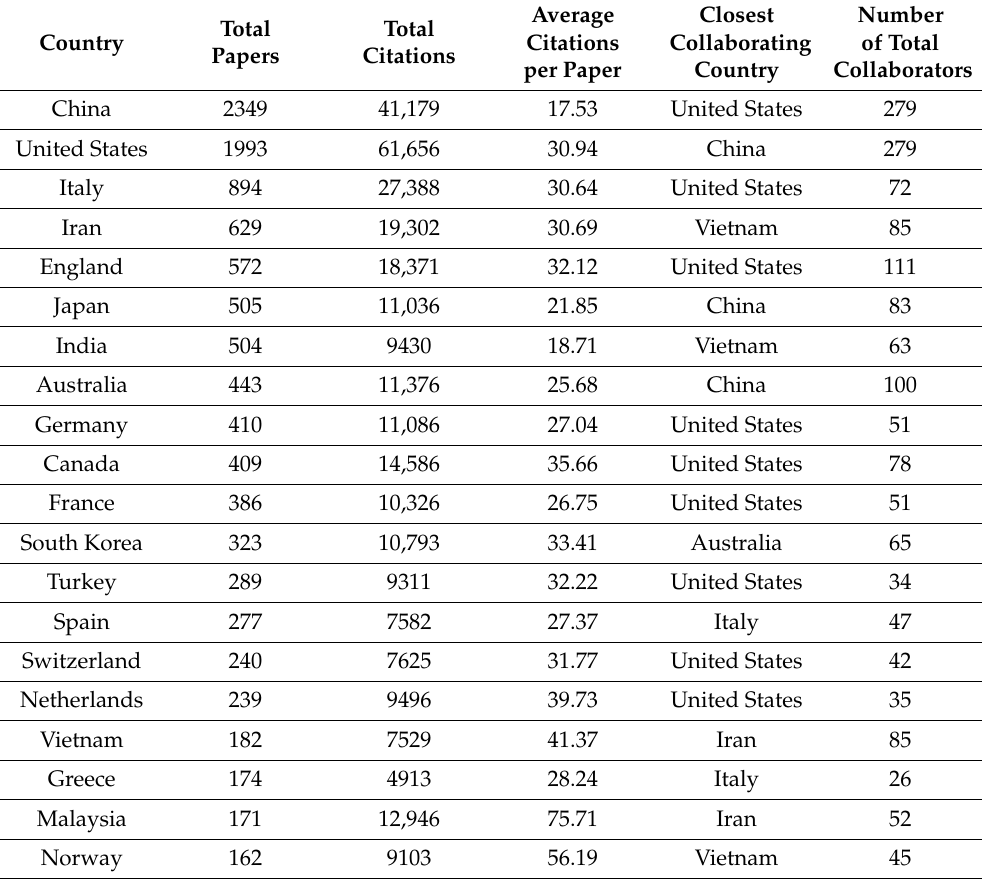
Table 4. Top 20 countries or regions in terms of number of